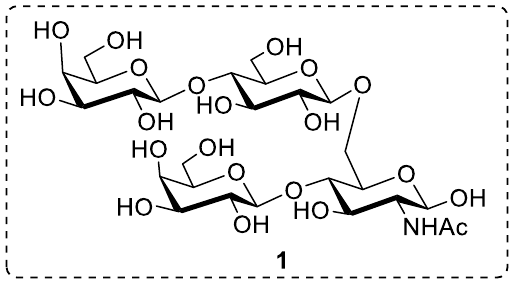
Figure 1. Identified smallest immunogenic fragment of S. pneumoniae type 14 capsular polysaccharide (CPS).